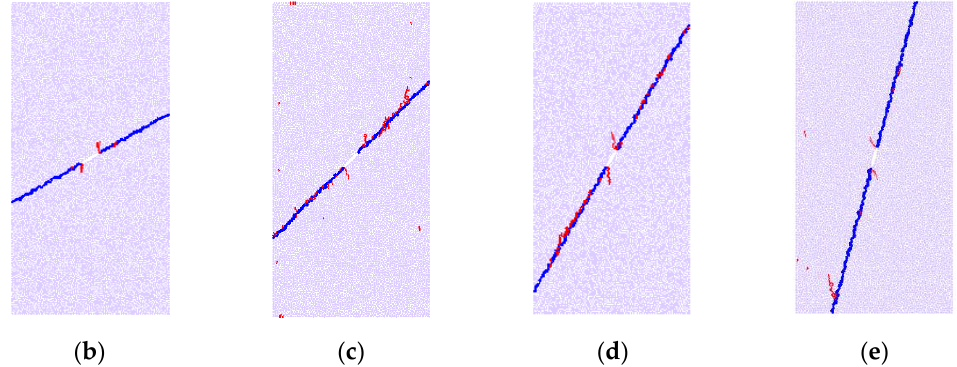
Figure 8. Stress – strain curves of real tests and numerical results: ( a ) sandstone; ( b ) granite. Table 4. Microscopic parameters of numerical models. Parameters Sandstone Granite